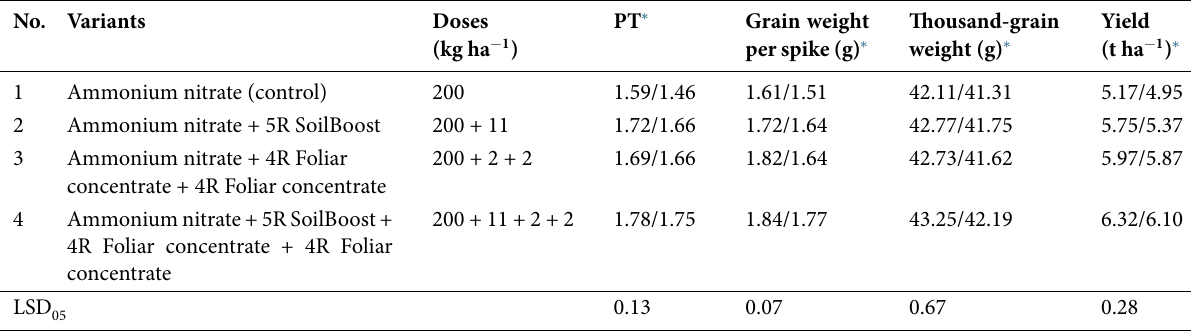
Table 3 e effects of the applied fertilizer system in the winter wheat yield, and yield components of the ‘Smuhlyanka’ and ‘Slavna’ cultivars.